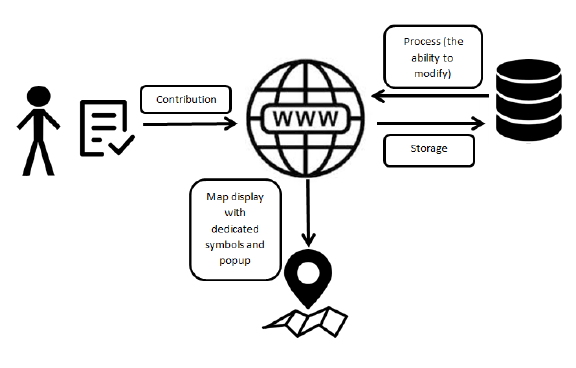
Figure 7. Figure data flow